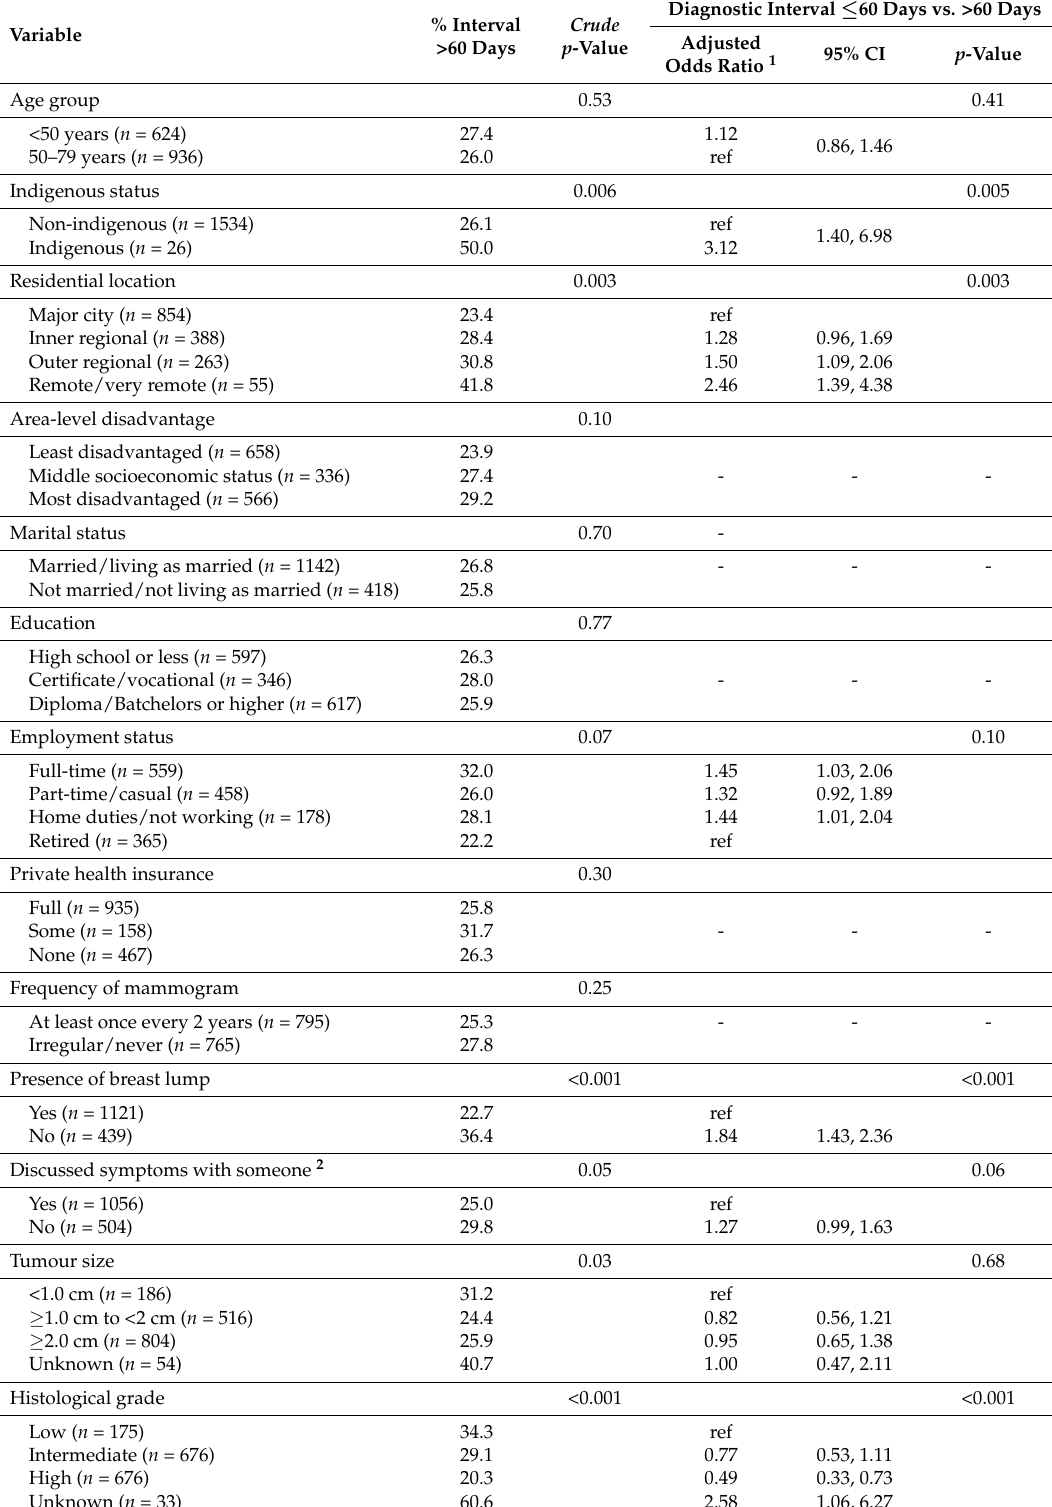
Table 1. Relationship between diagnostic interval and sociodemographic and clinical variables amongst 1560 women in Queensland, Australia with symptom-detected breast cancer: results of logistic regression